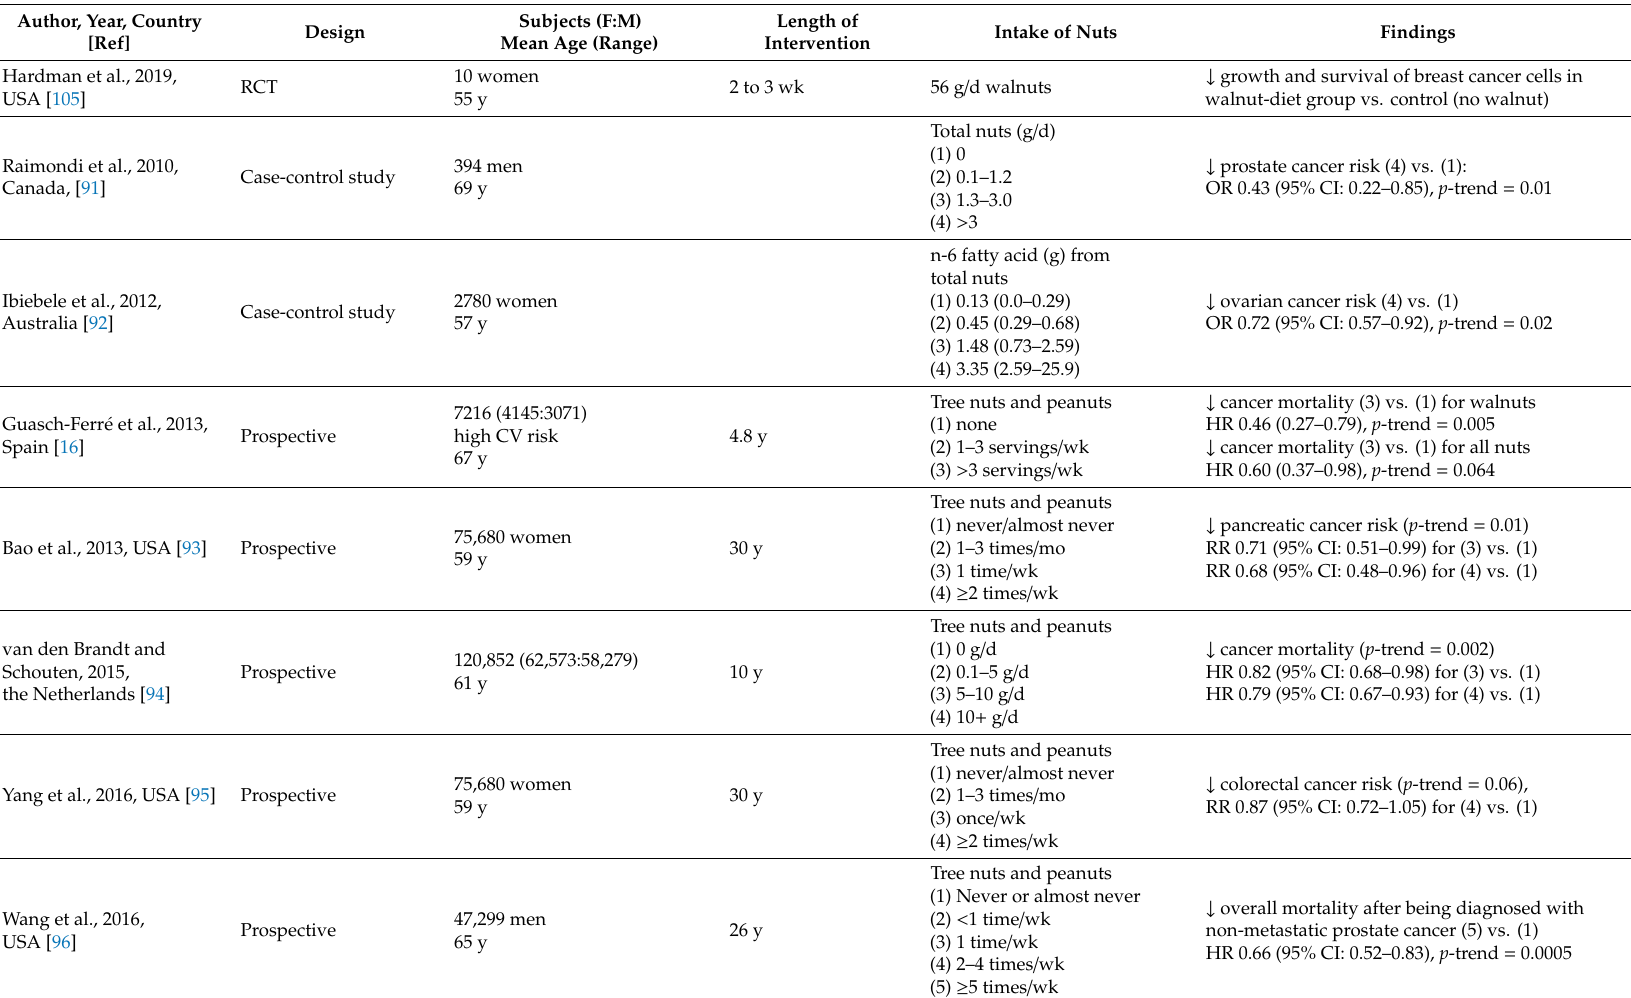
Table 5. Association between nut consumption and